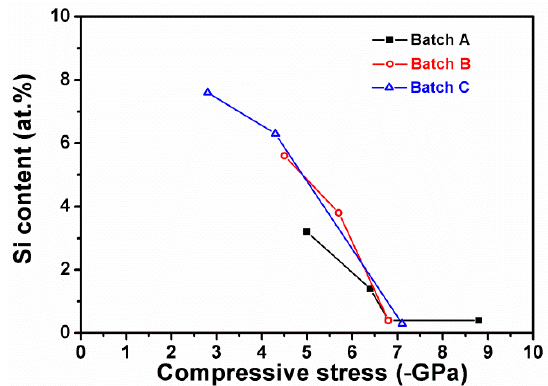
Figure 1. Relationship between Si content and residual stress of Zr–Si–N films.